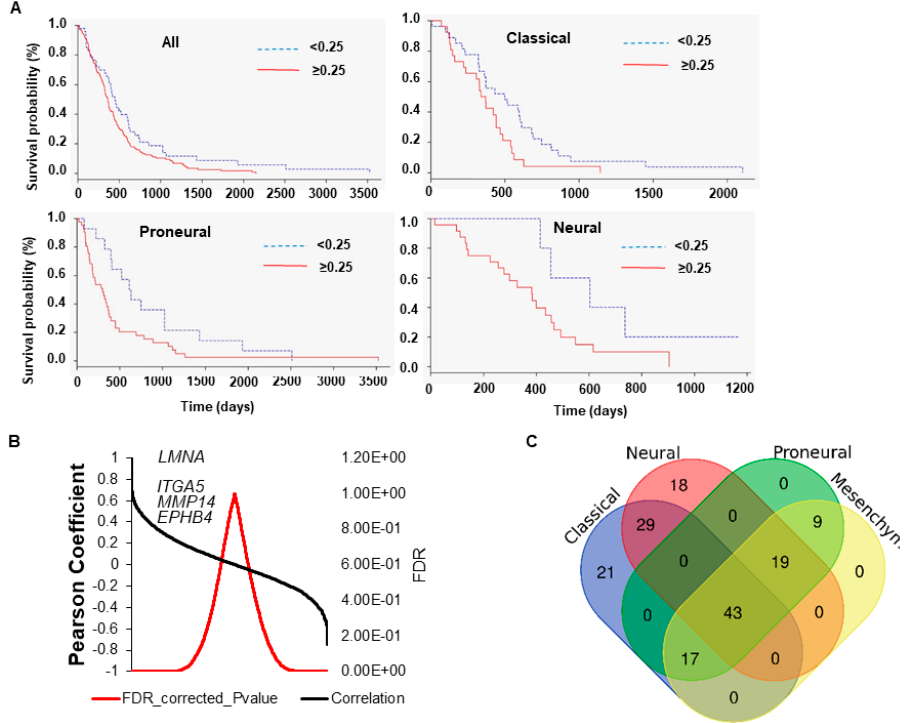
Figure 2. Analysis of LMNA gene expression in GBM patients from [8] microarray data. ( A ) Kaplan-Meier overall survival curves comparing LMNA high ( ≥ 0.25) and low (<0.25) from the TCGA database in GBM all (Z = 2.0; Log-Rank p -value = 4.1 × 10 − 2 ), classical (Z = 2.0; Log-Rank p -value = 4.4 × 10 − 2 ), proneural (Z = 2.3; Log-Rank p -value = 2.0 × 10 − 2 ) and neural (Z = 2.0; Log-Rank p -value = 4.0 × 10 − 2 ) group of patients. ( B ) Correlation analysis between LMNA gene and all other reported in the [8] microarray data. Correlation data are reported in Pearson coefficient and error data in FDR. ( C ) Venn diagram showing the enriched KEGG pathways in the different GBM subtypes of the [8] microarray database.